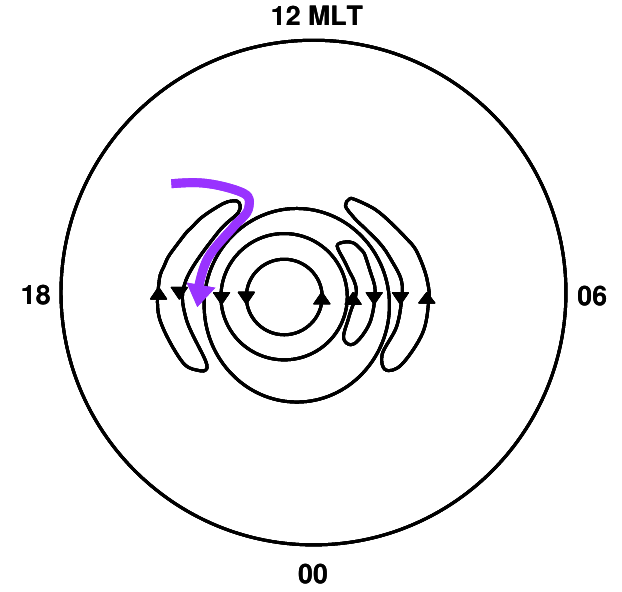
Figure 9: Schematic showing the TOI being drawn around the periphery of the polar cap under conditions of IMF Bz positive. The purple curve indicates the TOI, and the streamlines are representative of the plasma convective flow under the pertinent IMF conditions.